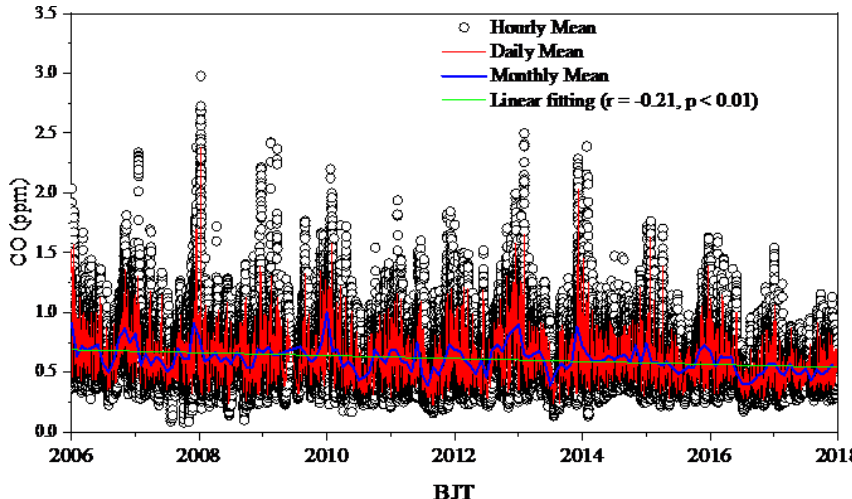
Figure 2. Time series of the CO variations at the LAN station from 2006 to 2017.